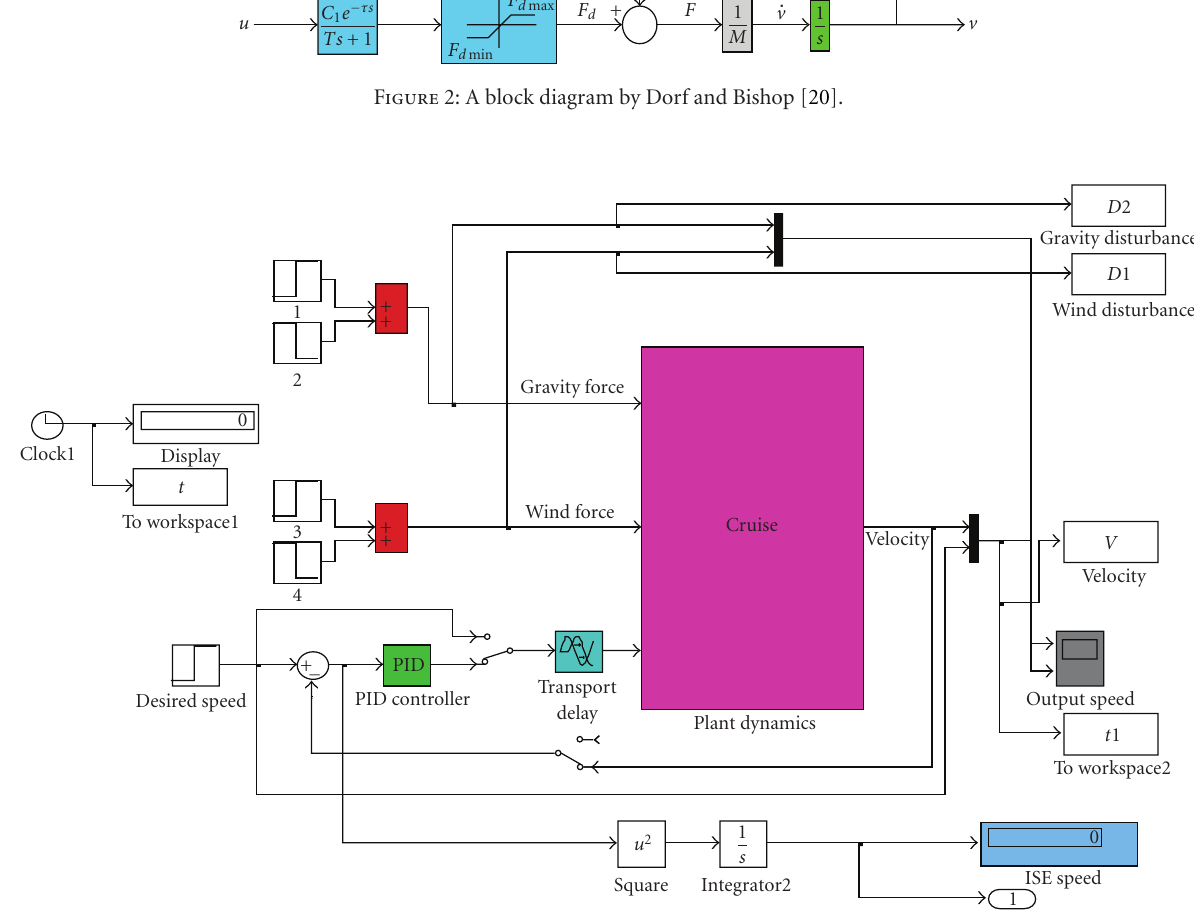
Figure 3: MATLAB SIMULINK block diagram for the nonlinear model of cruise control system using PID controller.